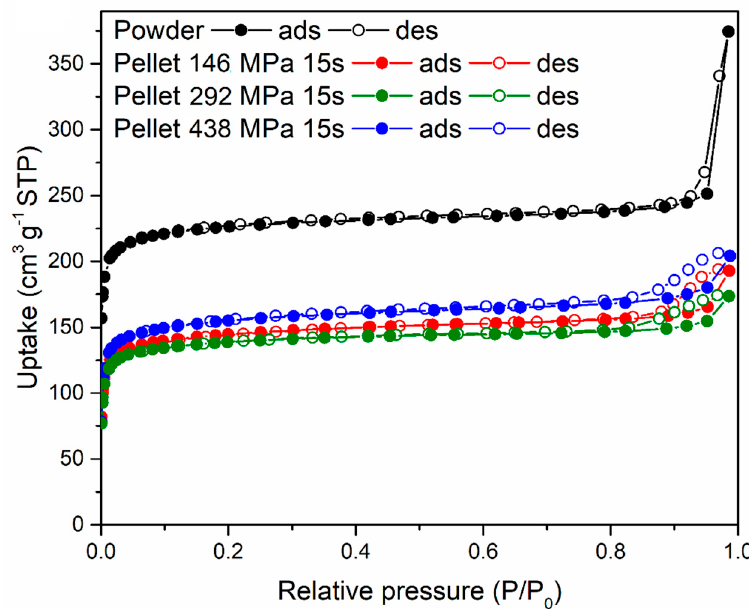
Figure 9. N 2 sorption isotherms at 77 K for MOF-801 powder (black) and pellets containing 5 wt